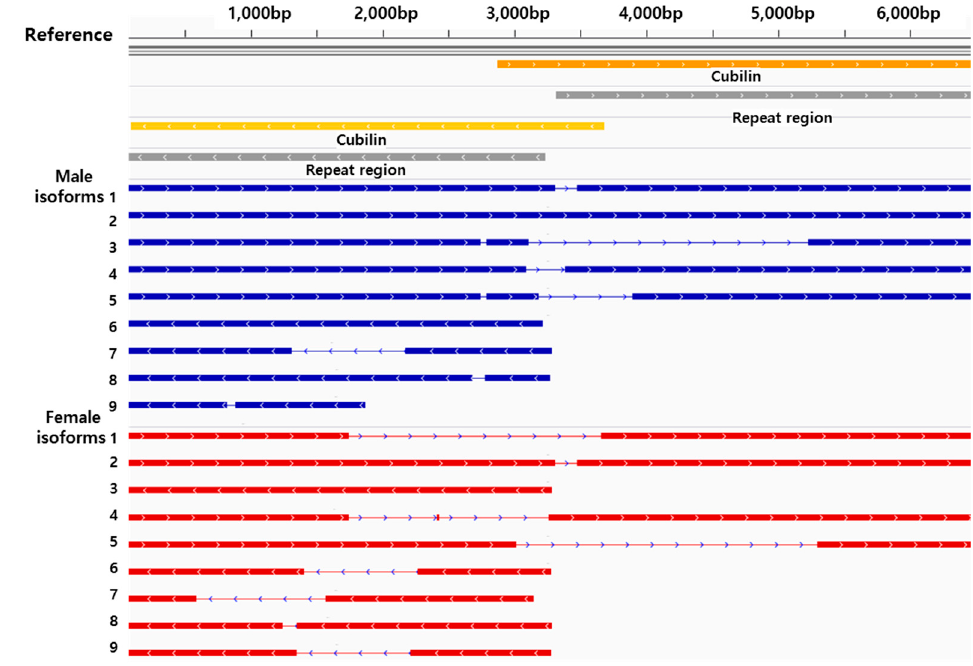
Figure 5. Cubilin isoforms in female and male Pacific abalone. Cubilin isoforms were determined by mapping consensus sequences to cubilin reference genes. Nine isoforms were defined in both female and male abalone, but only three isoforms showed the sequence in both sexes.